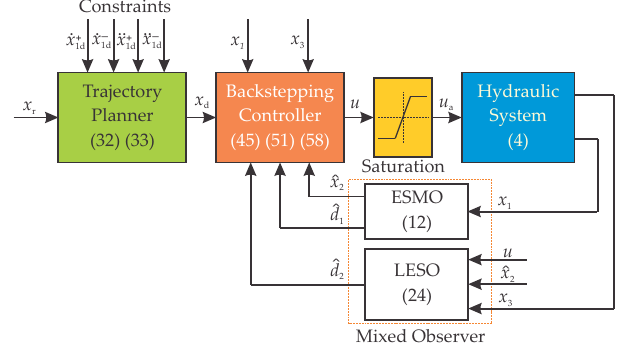
Figure 2. The proposed control